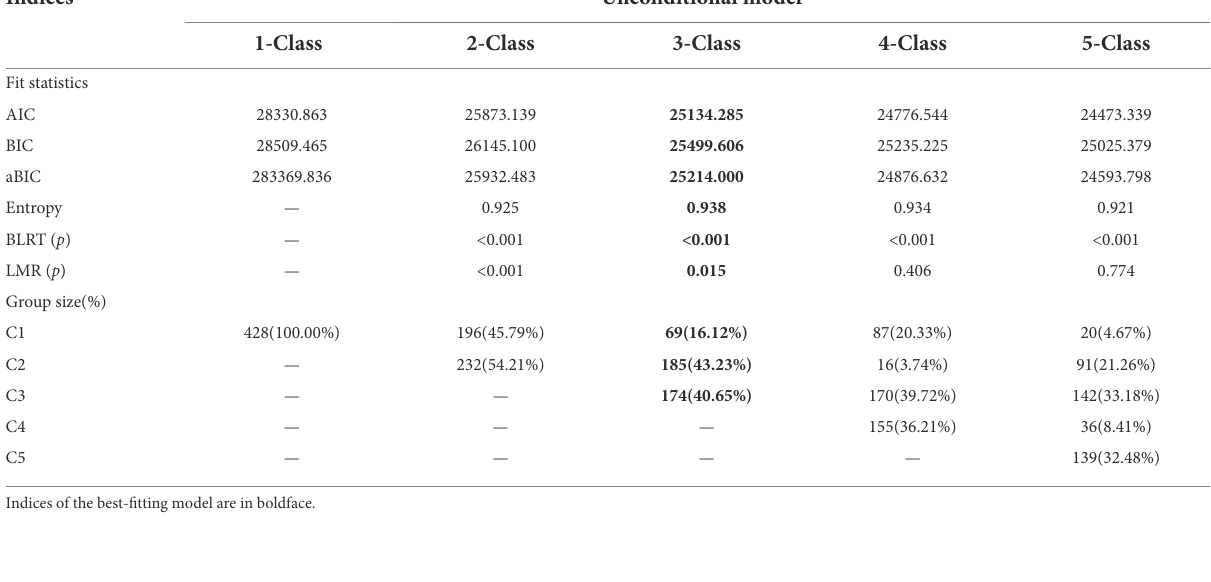
TABLE 3 Fitting index and group size of latent analysis models.